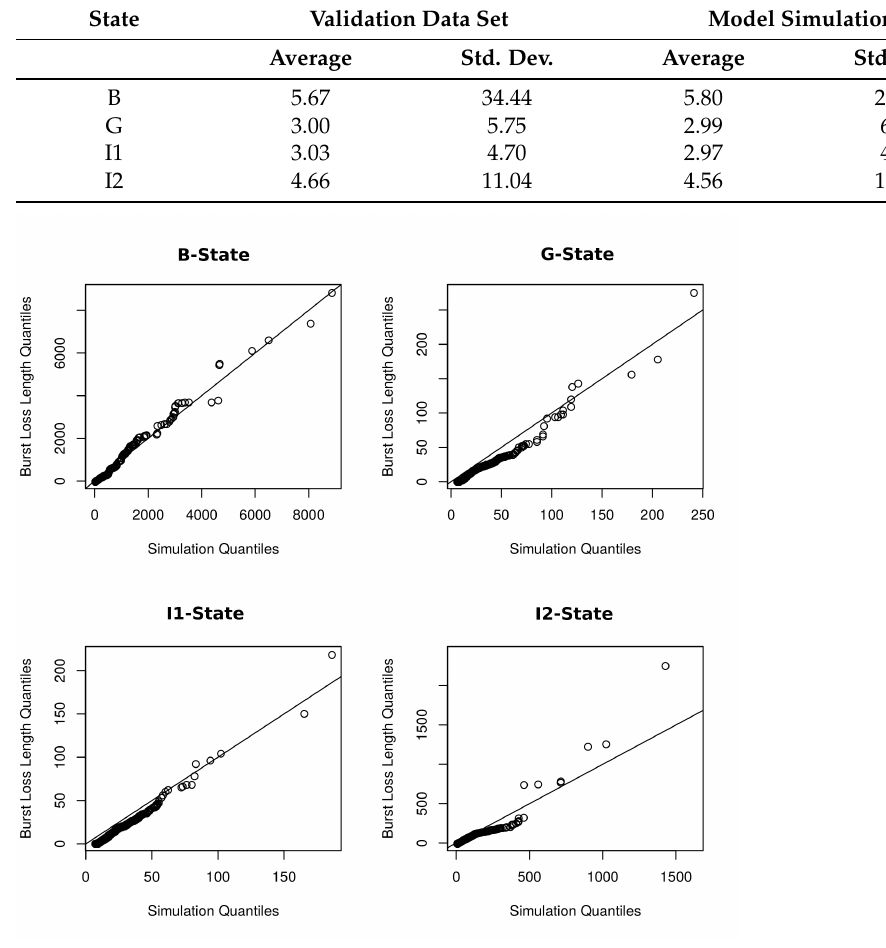
Figure 8. QQ-Plot of burst length of HMM 4 states and simulation